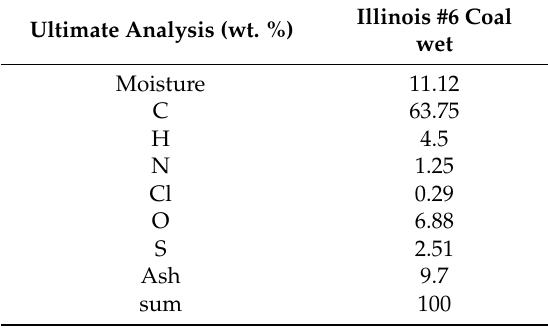
Table 3. Ultimate analysis of feedstock